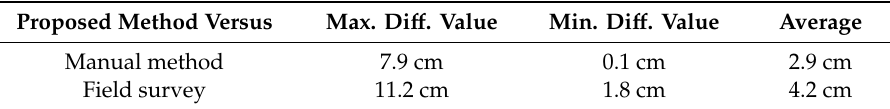
Table 3. Difference surfaces statistics values.